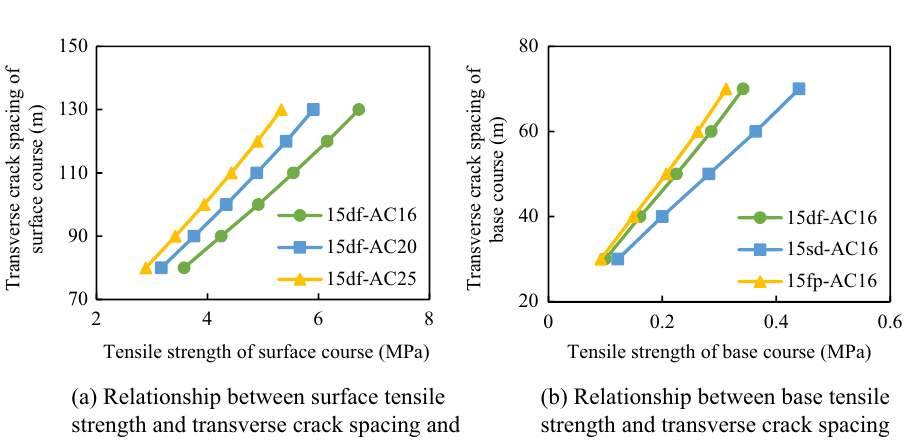
Figure 16. Relationship between transverse crack spacing and structural layer thickness of the pavement composite structure.